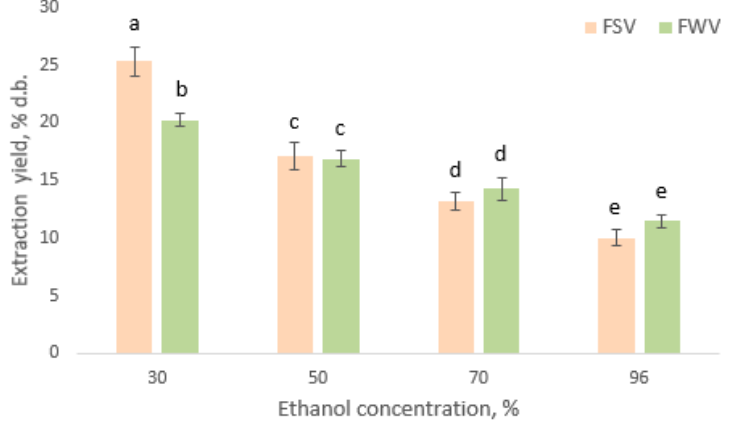
Figure 1. Extraction yield (% dry basis) of seed extracts of FSV and FWV at different ethanol concentrations in the extract solutions. Means not bearing a same letter are significantly different ( p < 0.05).